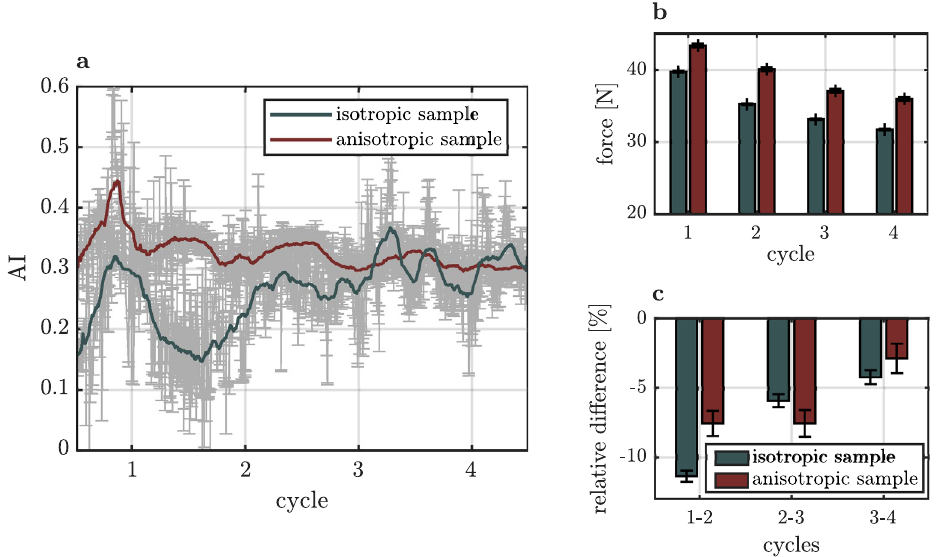
Figure 5. Relation between measured force and orientation of the collagen fiber network. ( a ) Alignment index of the isotropic sample and the anisotropic sample as a function of the deformation cycle number. ( b ) Relative maximum force applied to the isotropic and the anisotropic sample as a function of the deformation cycle number. ( c ) Relative difference of the maximum force of each deformation cycle of the isotropic and the anisotropic